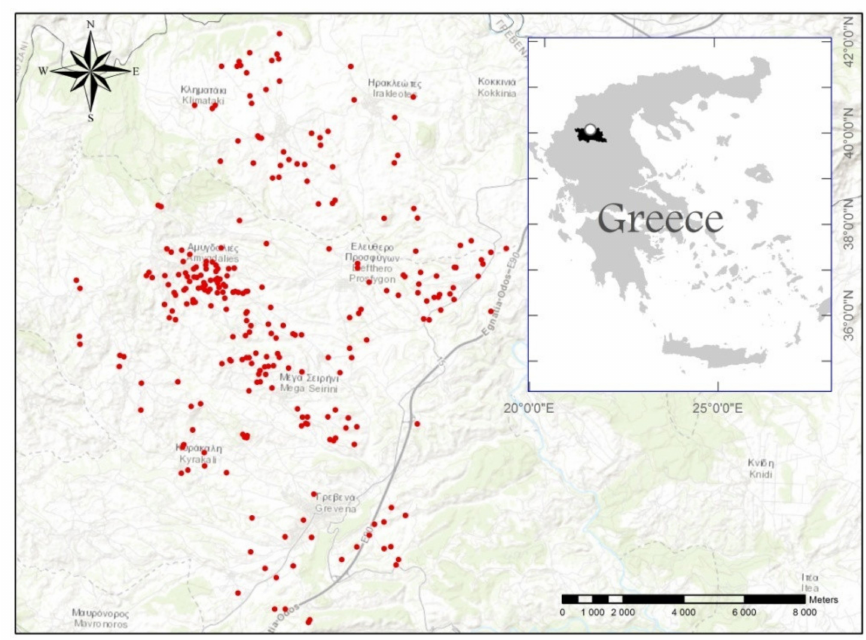
Figure 1. The 266 survey points and the study area (Grevena, Greece).